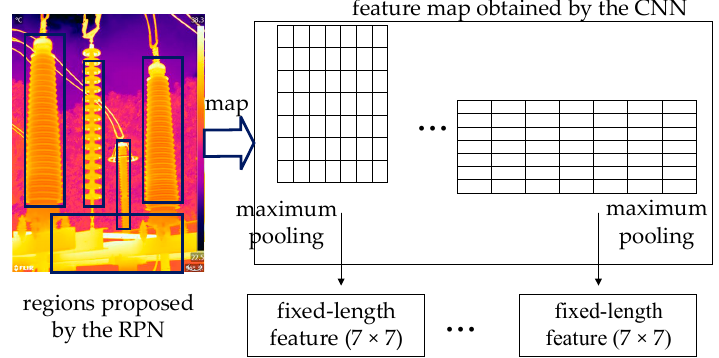
Figure 5. Pooling process of RoI pooling layer.